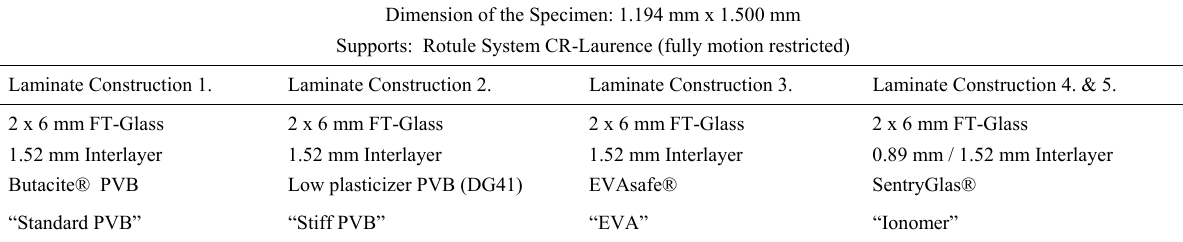
Table 2. Glazing